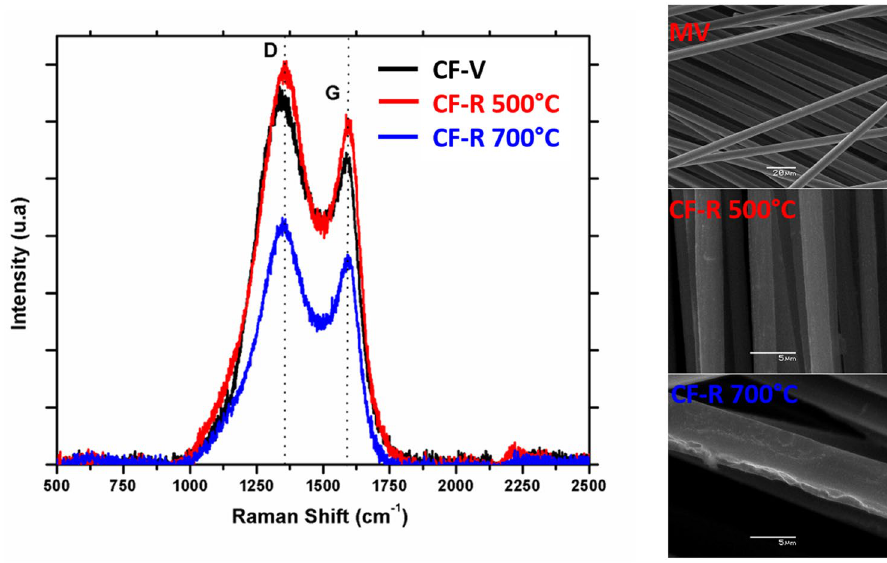
Figure 3. Raman spectroscopy of VCFs and RCFs at 500 °C and 700 °C.